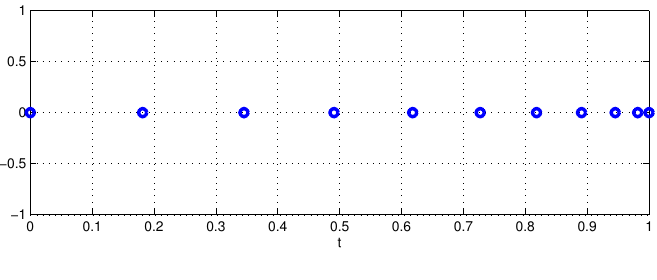
Figure 1. Non-uniform grid for N =